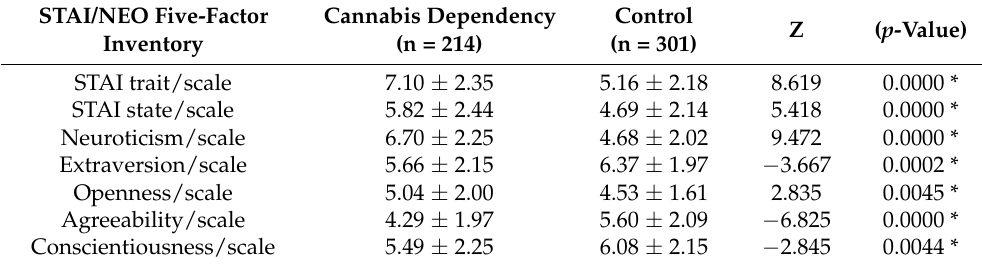
Table 3. STAI and NEO Five-Factor Inventory sten scores between healthy controls and Cannabis